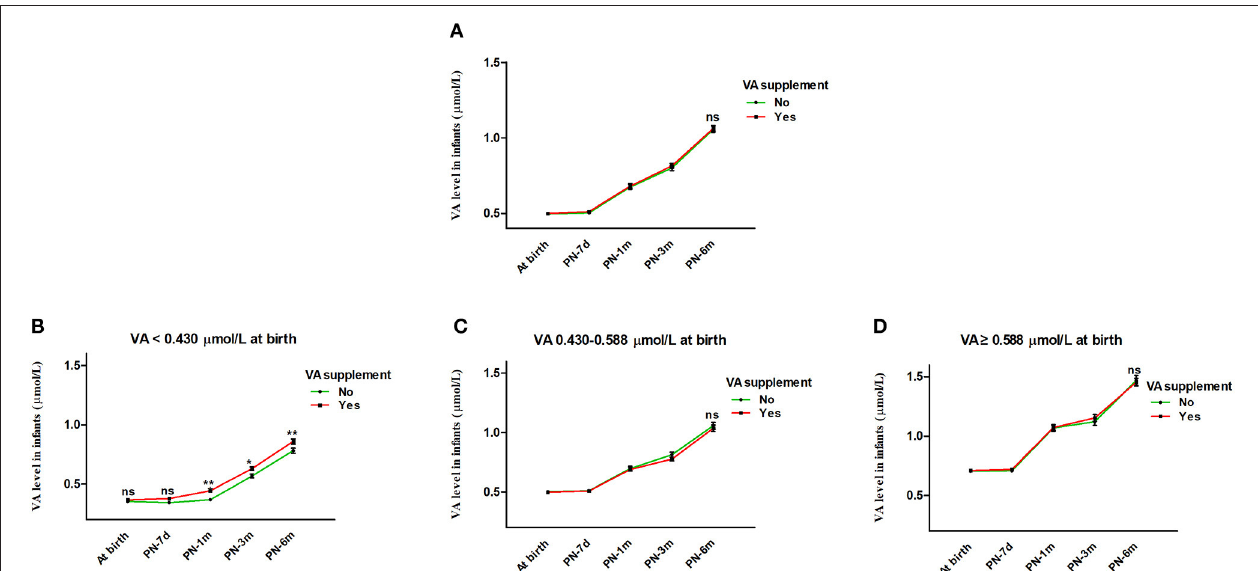
FIGURE 3 | Effect of VA supplementation on infant serum VA level with age. (A) Effect of VA supplementation on infant serum VA level with age from birth to 6 months. (B–D) Infants were stratified by VA level at birth into VA < 0.430 µ mol/L, VA 0.430-0.588 µ mol/L and VA ≥ 0.588 µ mol/L groups. (B) Effect of VA supplementation on infant serum VA level with age in the VA < 0.430 µ mol/L group. (C) Effect of VA supplementation on infant serum VA level with age in the VA 0.430-0.588 µ mol/L group. (D) Effect of VA supplementation on infant serum VA level with age in the VA ≥ 0.588 µ mol/L group. The values are the mean ± SEM. Generalized estimating equations with Bonferroni post hoc test, controlling for the effects of feeding pattern (Breast feeding vs. Mixed feeding vs. Artificial feeding) and sex (Female vs. Male). *Significant difference (* p < 0.05, ** p < 0.01) in VA levels between different groups according to VA supplementation at that visit, ns: no significant difference in VA level between different groups according to VA supplementation at that visit (B) or for all visits (A,C,D) . VA, vitamin A; PN-7d, postnatal day 7; PN-1m, postnatal month 1; PN-3m, postnatal month 3; PN-6m, postnatal month